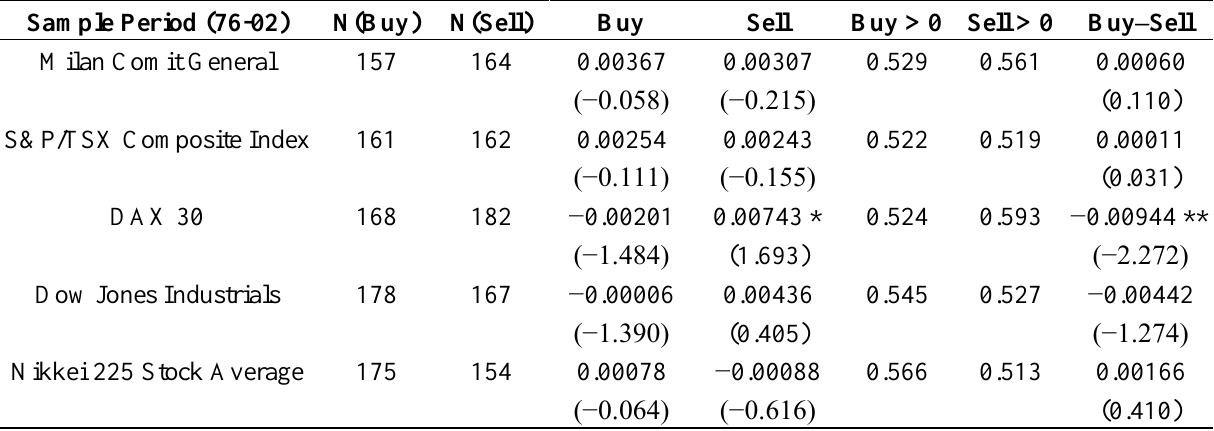
Table 2B. Average ten-day returns from MACD